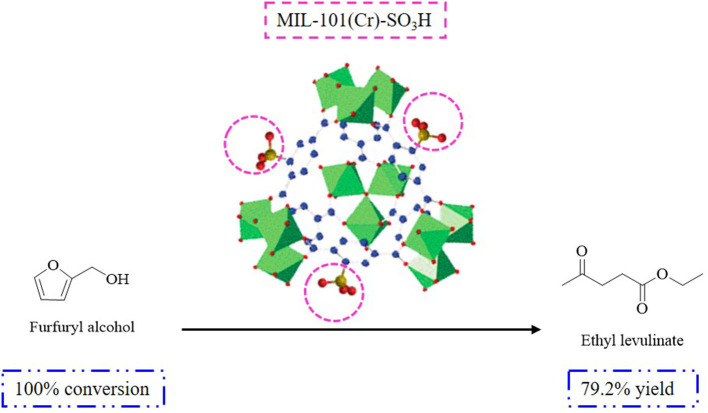
Reaction route for the conversion of FAL to EL over MIL-101(Cr)-SO3H.